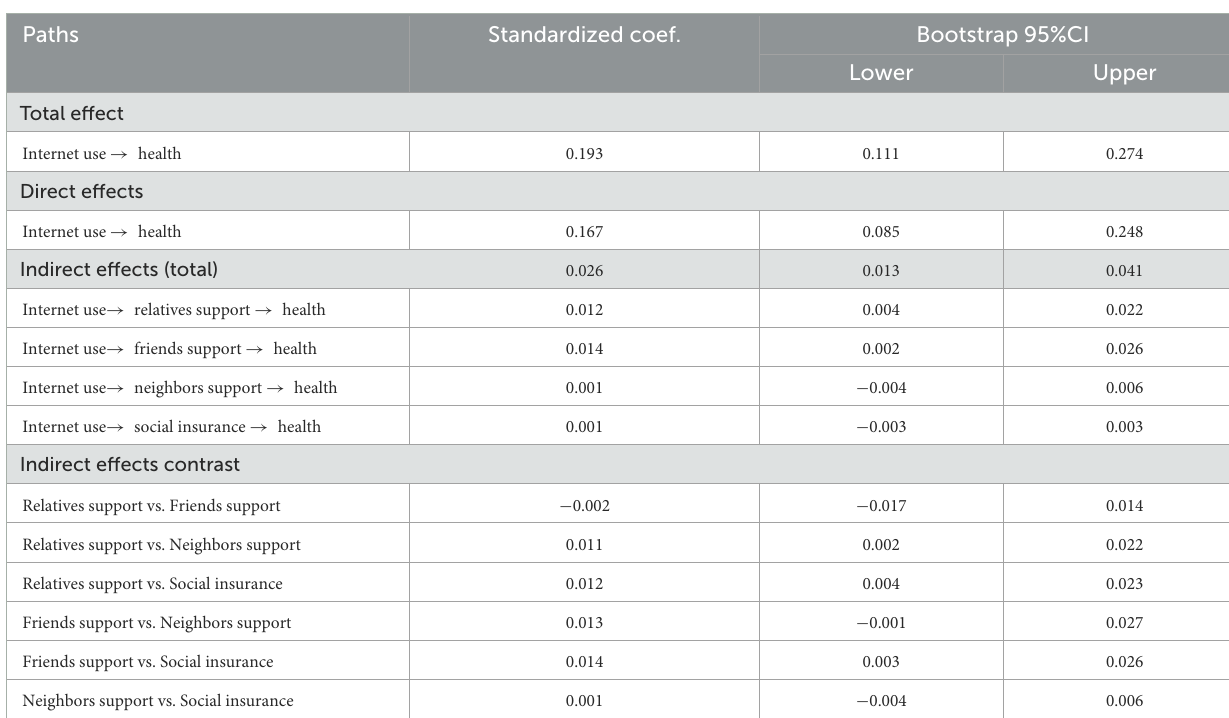
TABLE 6 Mediating effects of social